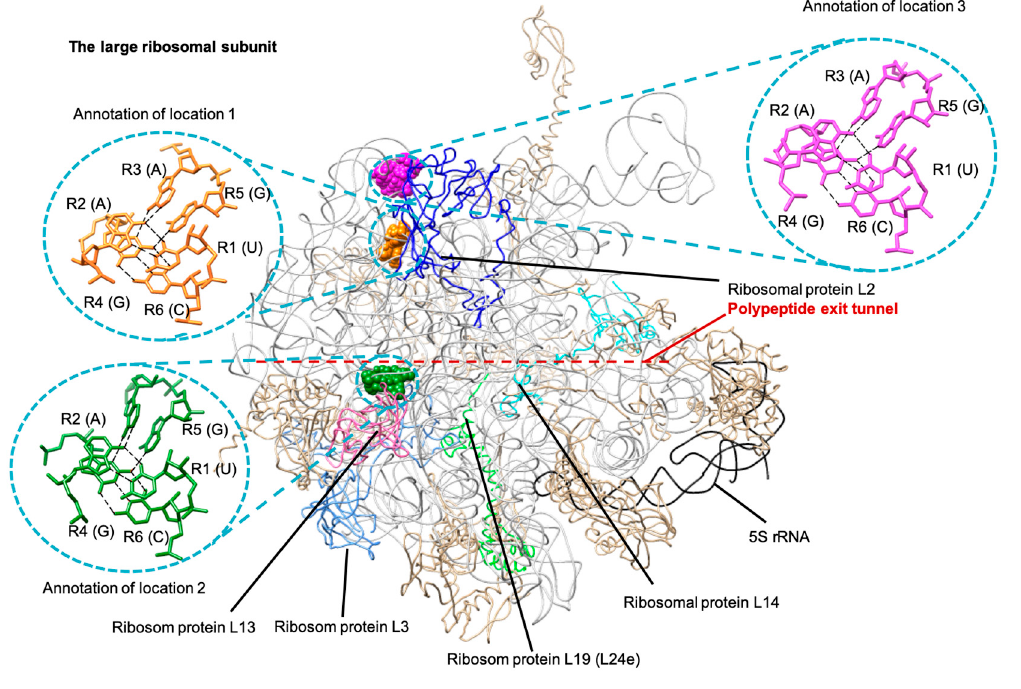
Figure 5. The UAAGAC base clusters that were annotated in three different locations in the large ribosomal subunit crystal structures are presented as colored spheres (PDB ID: 4LT8) [34].